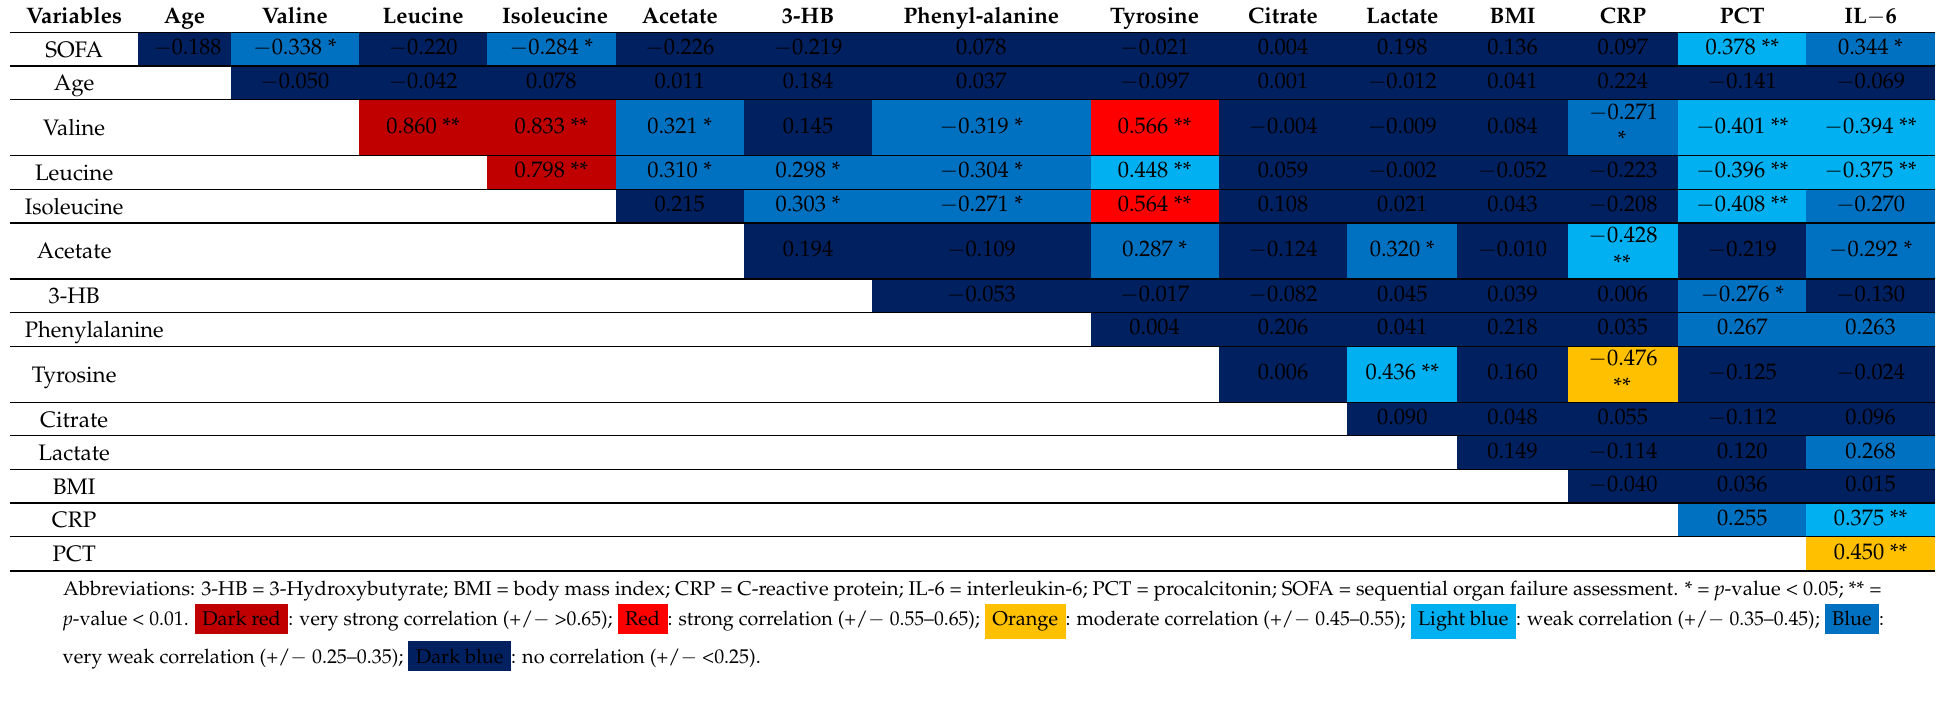
Table 4. Heatmap of correlations of selected variables and metabolites in the sepsis